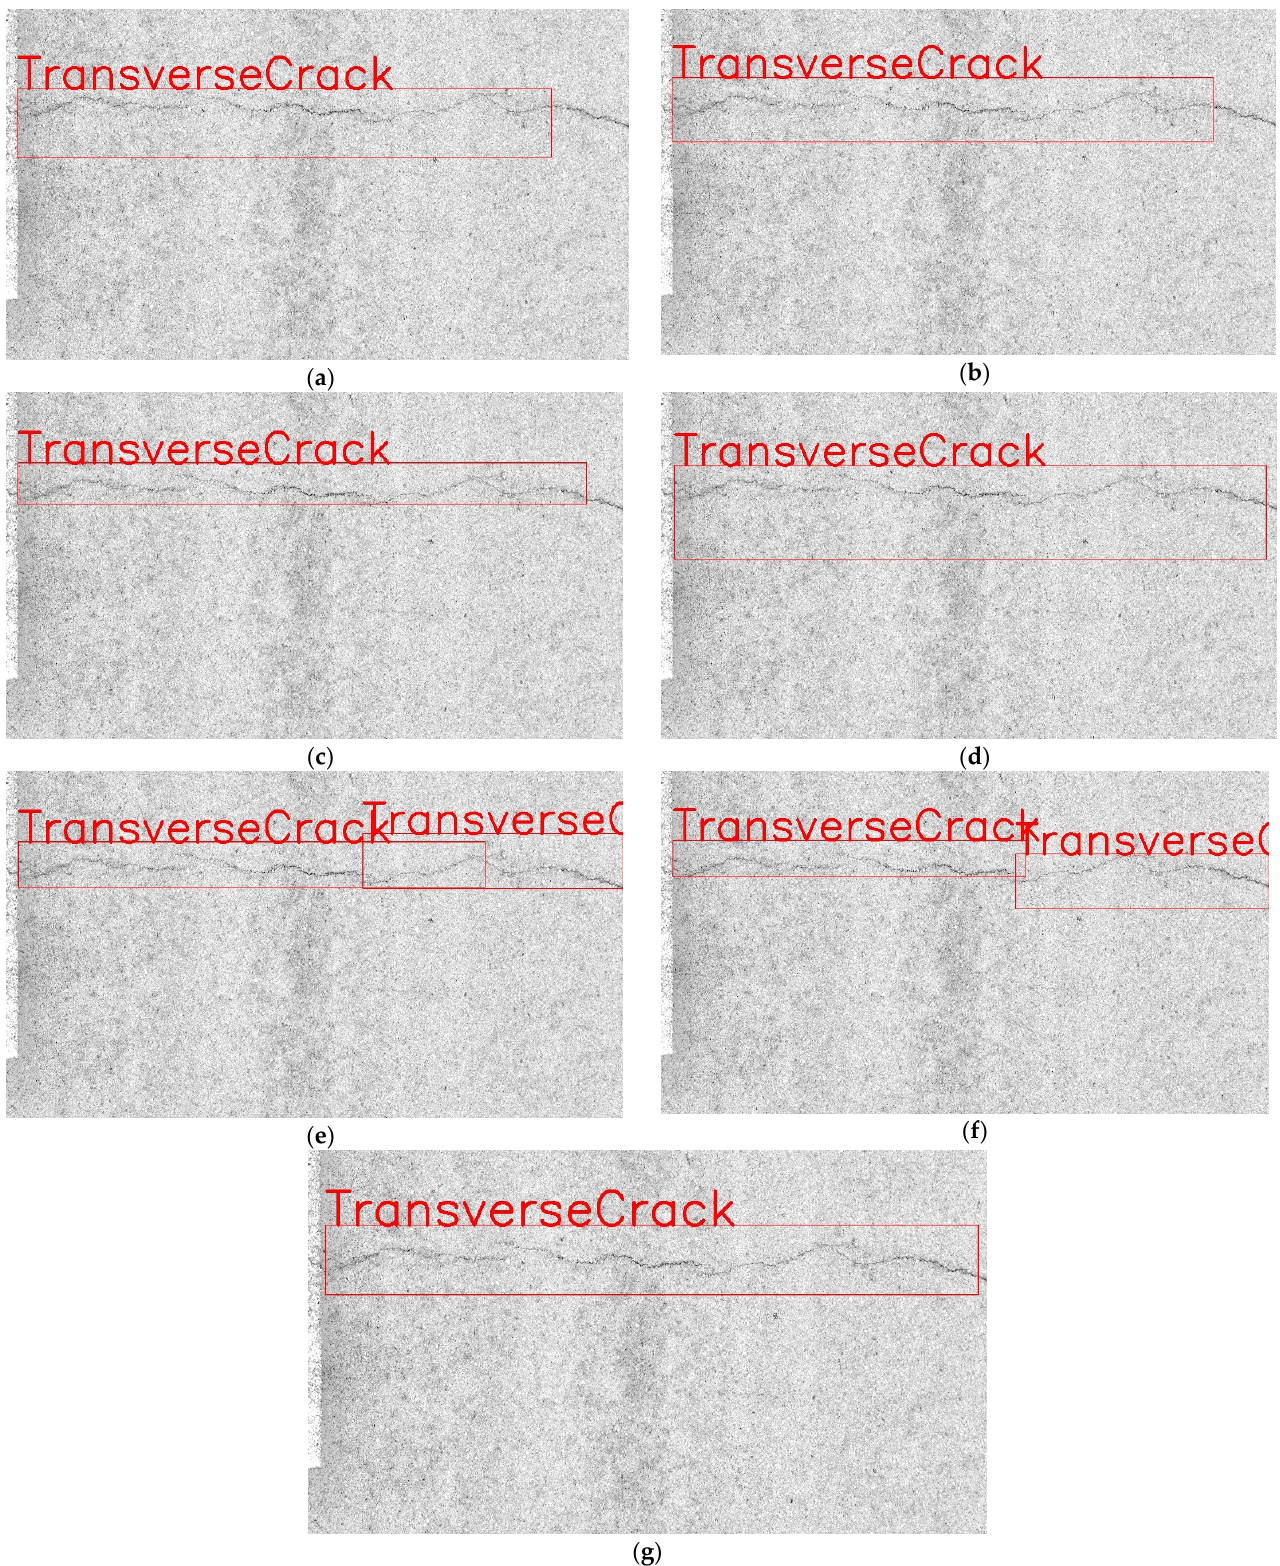
Figure 15. Detection results under different attention mechanisms. ( a ) Baseline. ( b ) Baseline + SE. ( c ) Baseline + CBAM. ( d ) Baseline + GC. ( e ) Baseline + ECA. ( f ) Baseline + SRM. ( g ) Baseline + SimAM.